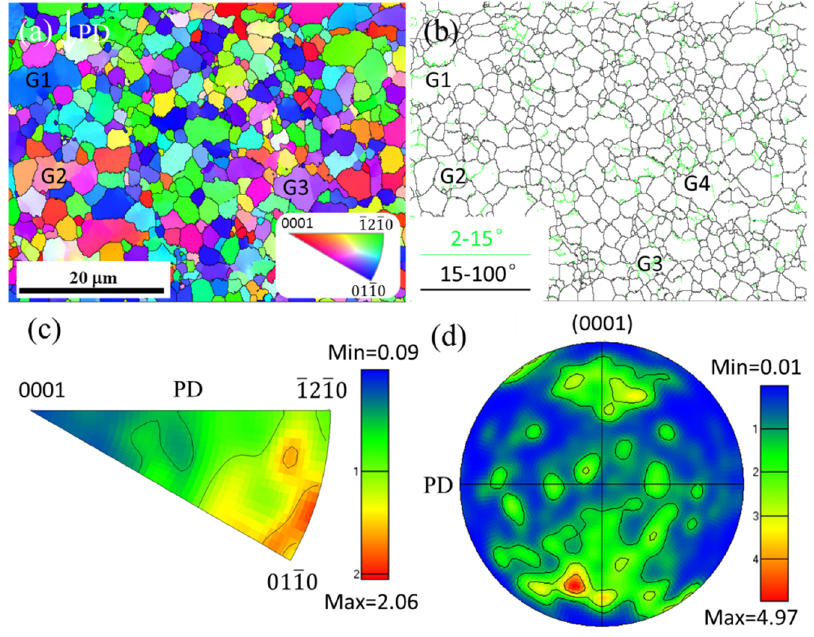
Figure 13. Inverse pole figure (IPF) map ( a ) of the compressed Ex-2 WE43 alloy after a true strain of 1.2 with a strain rate of 0.05 s − 1 along with its corresponding ( b ) boundary map, ( c ) typical IPF, and ( d ) (0001) basal pole figure (PF).